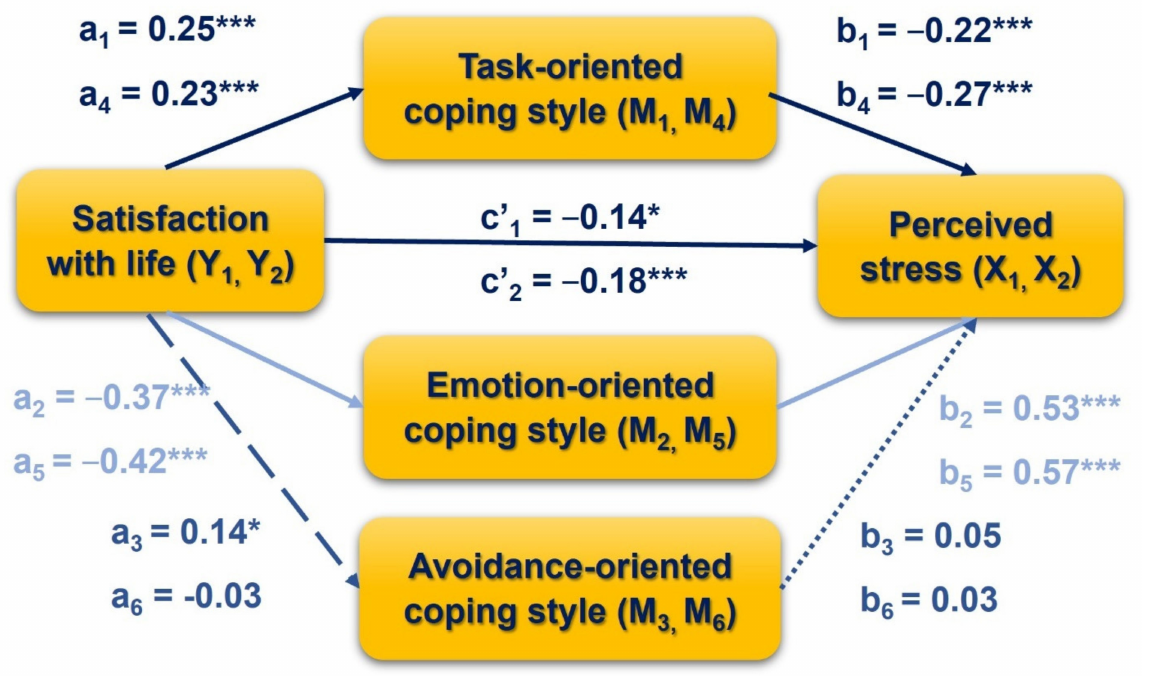
Figure 4. Path model of mediation for the effect of perceived stress on satisfaction with life, via coping styles; cross-sectional design (Model 3 and Model 4). * p < 0.05, *** p <